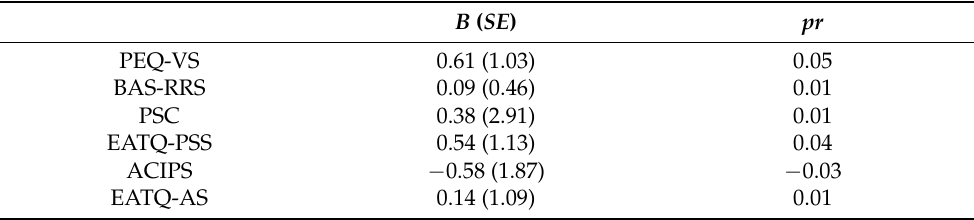
Table 4. Associations between NSSI status (as the independent variable) and self-report responses to negative and positive